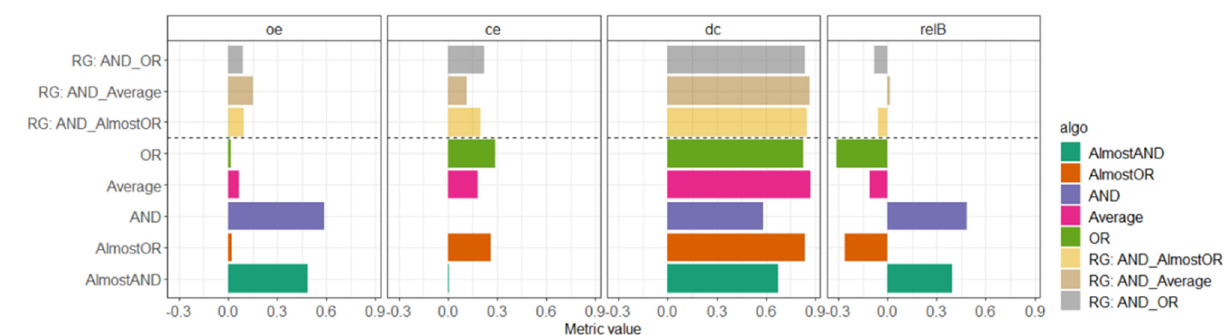
Figure 12. Accuracy metrics (omission error = oe, commission error = ce, Dice coefficient = dc and relative bias = relB) over the training site for burned area maps obtained with the RG algorithm (with three cases of growing layer, OWA Average , OWA Almost_OR and OWA OR ) and from segmentation of the OWA global evidence (from all tested OWAs).